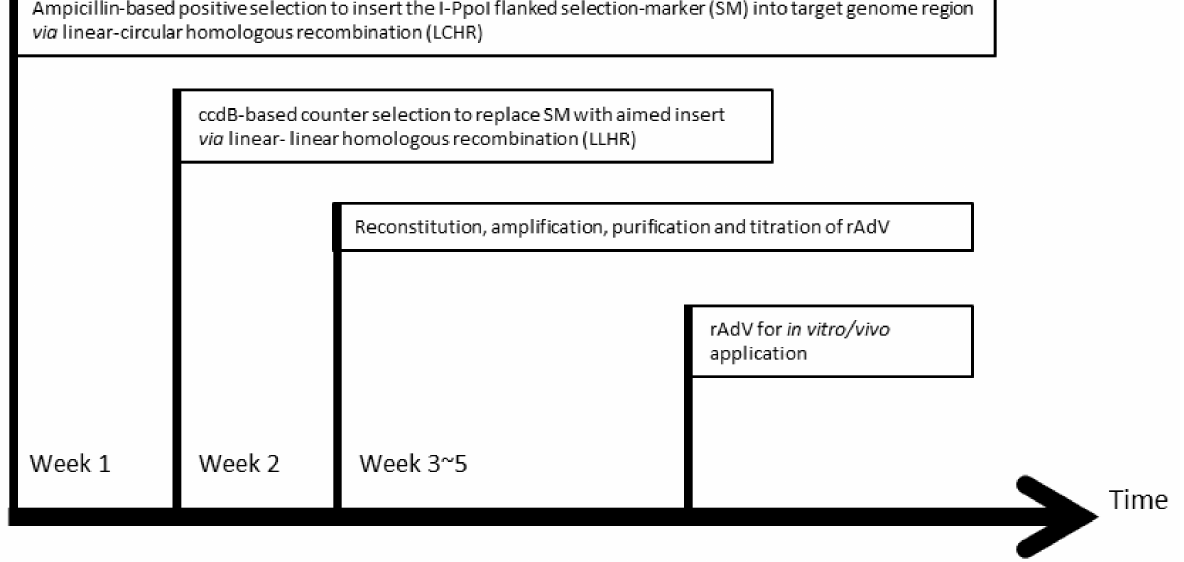
Figure 3. Timeline for adenovirus genome engineering with HEHR. It takes two weeks to generate a recombinant adenovirus vector. In the first week, a selection marker (SM) can be inserted into the target region of the adenoviral genome via linear-circular homologous recombination (LCHR); in the second week, the selection marker in the target site is replaced by the insert of choice via linear-linear homologous recombination (LLHR). Afterwards, the recombinant adenoviral vector can be reconstituted by transfection of the linearized plasmid into the producer cell line (such as HEK 293 cells) for further